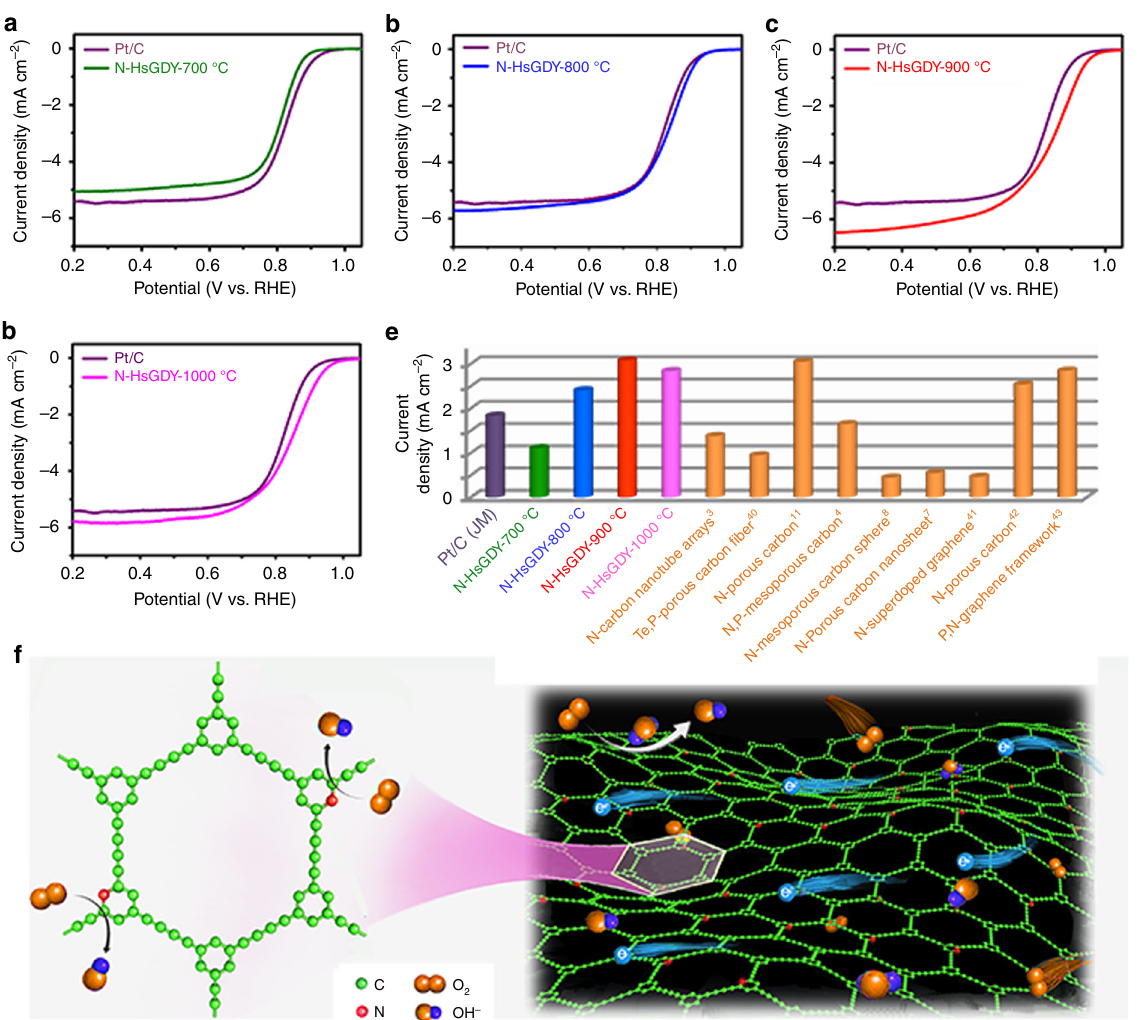
Fig. 4 Performance of catalysts in alkaline media. a – d Linear sweep voltammetry curves of pyridinic nitrogen-doped hydrogen-substituted graphdiyne (N-HsGDY) treated at 700 °C (N-HsGDY-700 °C) ( a ), N-HsGDY treated at 800 °C (N-HsGDY-800 °C) ( b ), N-HsGDY treated at 900 °C (N-HsGDY- 900 °C) ( c ), and N-HsGDY treated at 1000 °C (N-HsGDY-1000 °C) ( d ), compared to commercial carbon-based platinum catalyst (Pt/C (JM)) for the oxygen reduction reaction (ORR). e Comparison of current density at 0.85V vs. reversible hydrogen electrode (RHE) of Pt/C, N-HsGDY catalysts in